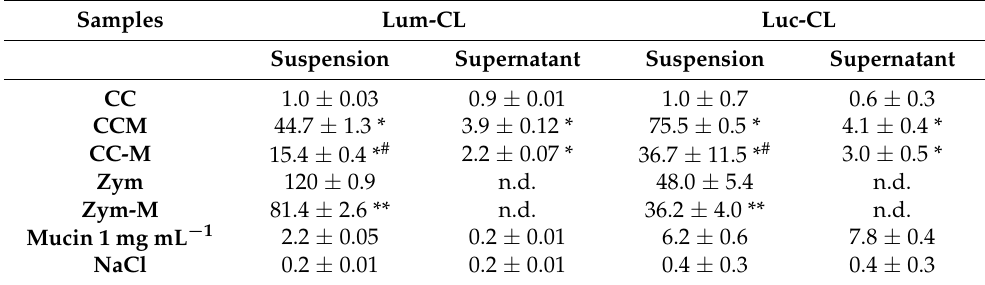
Table 1. Amplitude of Lum-CL and Luc-CL neutrophil response activated by microparticles and corresponding supernatant aliquots. Data of three independent experiments were normalized by the value of neutrophil response to CC microparticles and are represented in conventional units as average value and standard deviation. In each experiment, the values were measured in triplicate. Samples Lum-CL Luc-CL Suspension Supernatant Suspension Supernatant CC 1.0 ± 0.03 0.9 ± 0.01 1.0 ± 0.7 0.6 ± 0.3 CCM 44.7 ± 1.3 * 3.9 ± 0.12 * 75.5 ± 0.5 * 4.1 ± 0.4 * CC-M 15.4 ± 0.4 * # 2.2 ± 0.07 * 36.7 ± 11.5 * # 3.0 ± 0.5 * Zym 120 ± 0.9 n.d. 48.0 ± 5.4 n.d. Zym-M 81.4 ± 2.6 ** n.d. 36.2 ± 4.0 ** n.d. Mucin 1 mg mL − 1 2.2 ± 0.05 0.2 ± 0.01 6.2 ± 0.6 7.8 ± 0.4 NaCl 0.2 ± 0.01 0.2 ± 0.01 0.4 ± 0.3 0.4 ± 0.3 * p < 0.01 vs. CC. ** p < 0.01 vs. Zym. # p < 0.01 vs.